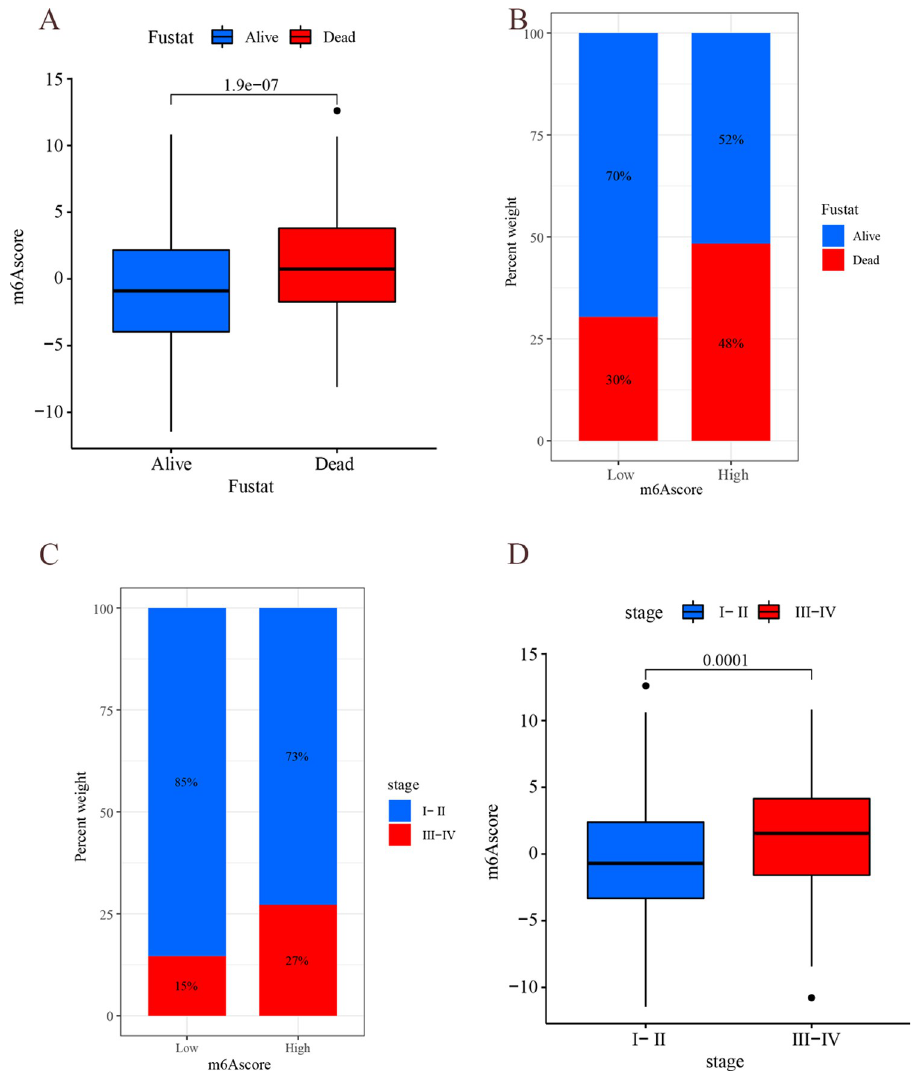
Fig 12. Results of m 6 A score analysis. (A) The horizontal coordinate indicates the survival state, and the vertical coordinate indicates m 6 A score. (B) The horizontal coordinate indicates m 6 A score group(high m 6 A score group or low m 6 A score group), and the vertical coordinate indicates survival rate (the red line indicates “Alive”, the blue line indicates “Dead”). (C) The horizontal coordinate indicates m 6 A score type(the red line indicates stage I-II, the blue line indicates stage III-IV), and the vertical coordinate indicates survival rate. (D) The horizontal coordinate indicates the stage, and the vertical coordinate indicates m 6 A